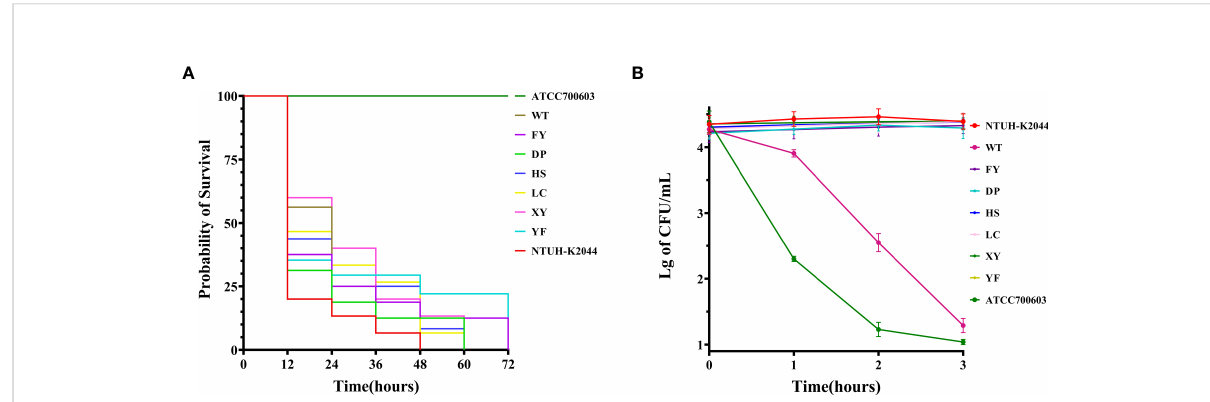
FIGURE 2 Virulence phenotypes of seven XDR-hvKp strains. (A) Survival curves of the Galleria mellonella larvae. (B) Activity of strains in serum from healthy human. The data are expressed as the Mean ± SE (standard error).In (A, B) , K. pneumoniae NTUH-K2044 and ATCC 700603 were used as positive control and negative control, respectively.